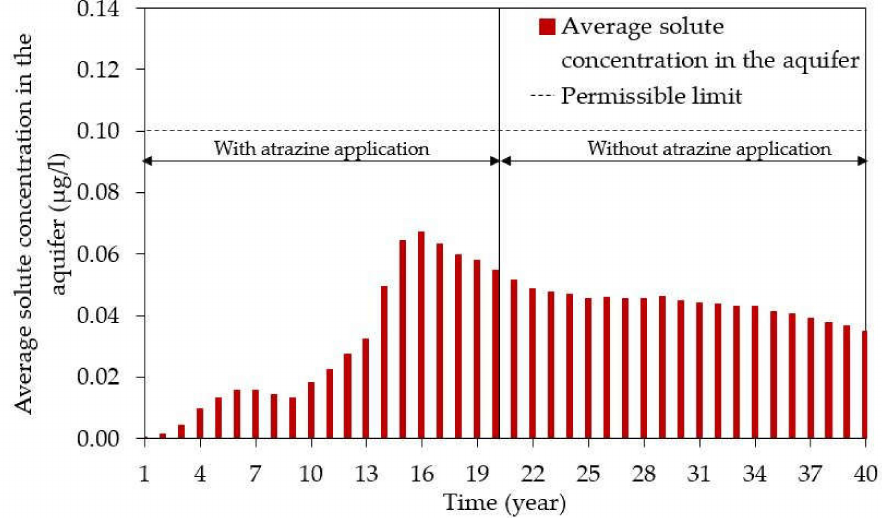
Figure 8. Average annual atrazine concentrations in the aquifer simulated using MODFLOW with the HYDRUS-1D package and